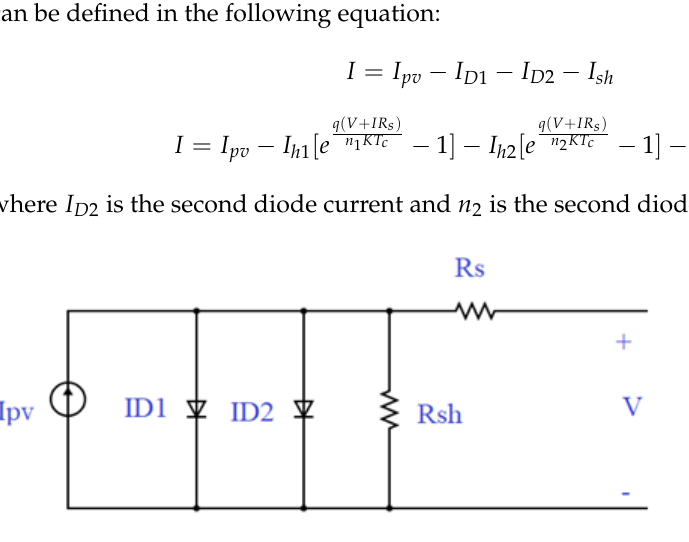
Figure 2. Equivalent circuit of the DDSCM.